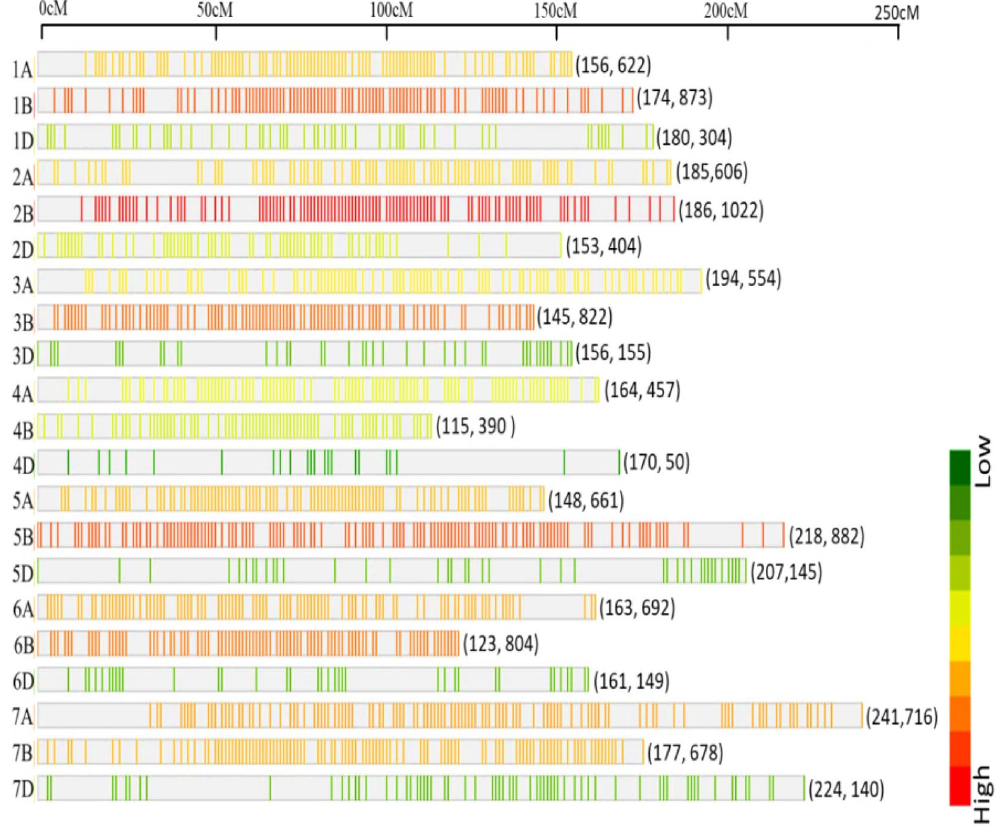
Figure 2. SNP density plot of the distribution of SNPs across all seven homoeologous chromosomes of wheat. The horizontal axis shows the length of the chromosome (cM); the SNP density is depicted by different colours.